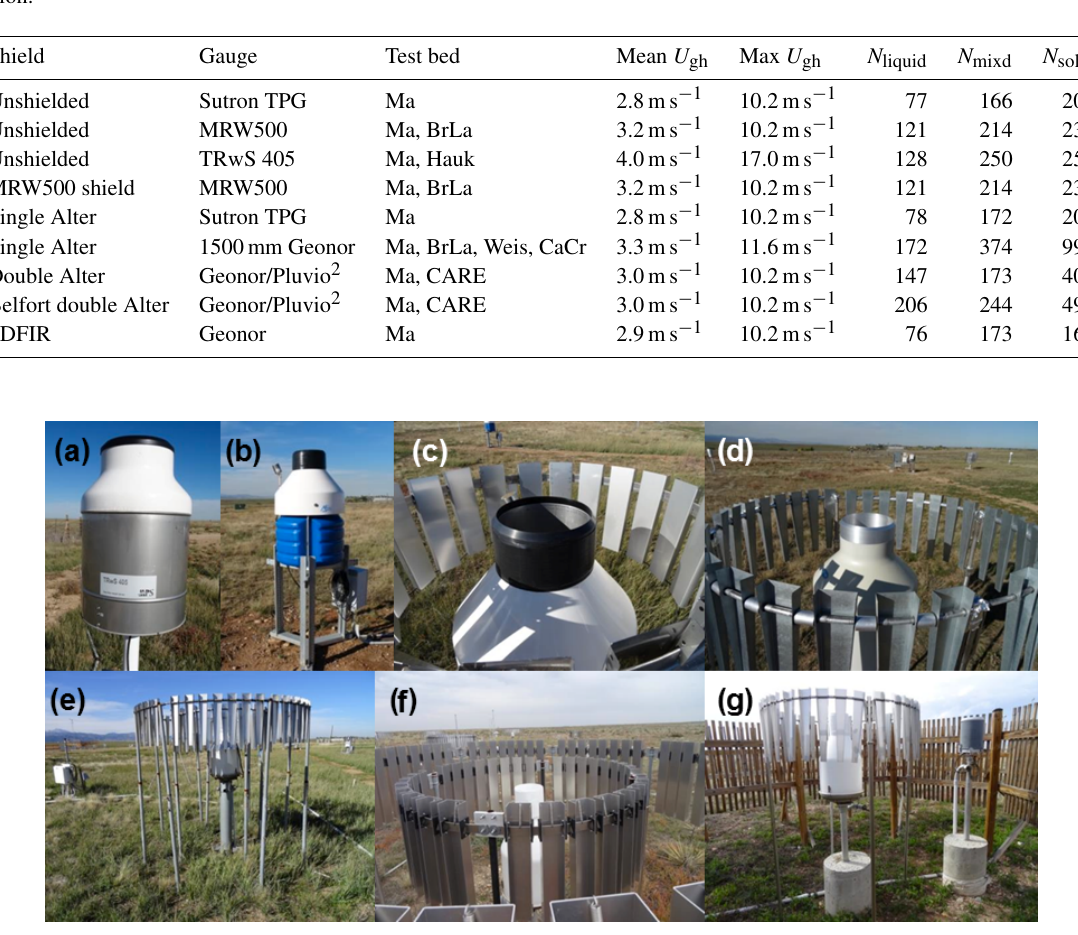
Table 2. Shield type, gauge type, test bed, mean and maximum (Max) of the measured wind speed at gauge height ( U gh ) , and the number of liquid ( N liquid ) , mixed ( N mixd ) , and solid ( N solid ) 30min precipitation measurements included in this study. The measurements for all gauges were recorded during the two winter seasons (1 October–30 April) of 2013–2015. Wind speed statistics only describe periods of precipitation.